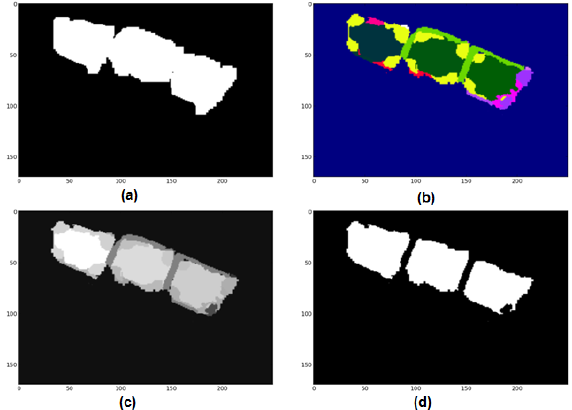
Figure 7. (a) Building candidate area. (b) Segments after merging. (c) Average height of the Segments. (d) Building footprint after applying the local